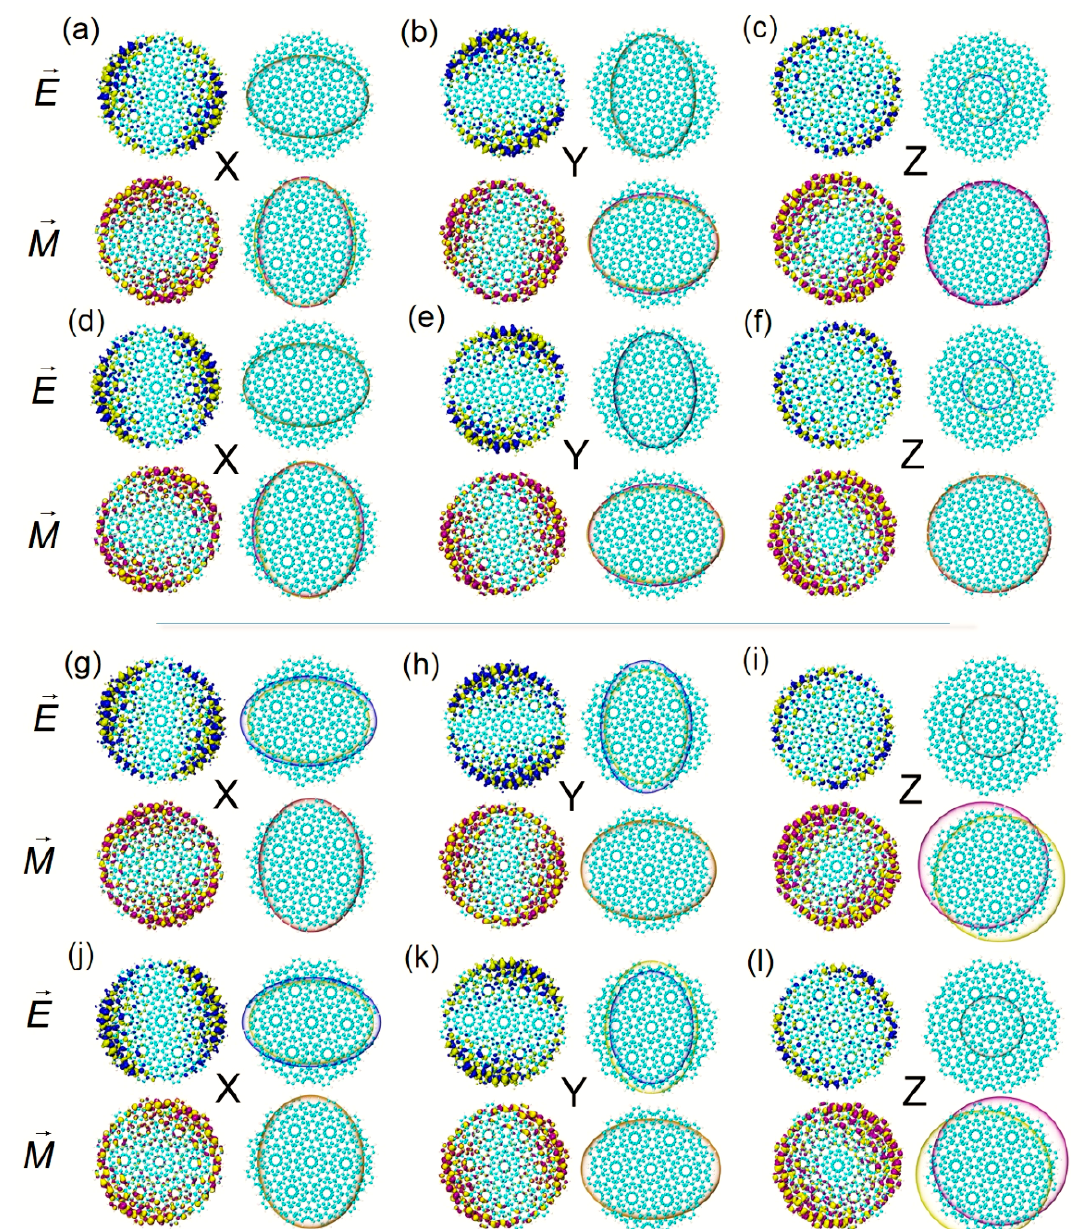
Figure 4. The theoretical calculation of TEDM (yellow isosurface represents a negative value, blue isosurface represents positive value) and TMDM (yellow isosurface represents a negative value, purple isosurface represents positive value) of Z-TwBLG-QDs-27.8° and Z-TwBLG-QDs-32.2° at S 51 and their TEDM S and TMDM S of Cartesian components ( a – c , d – f ), respectively. TEDM and TMDM of Z-TwBLG-QDs-27.8° and Z-TwBLG-QDs-32.2°, and their TEDM S and TMDM S of Cartesian com-